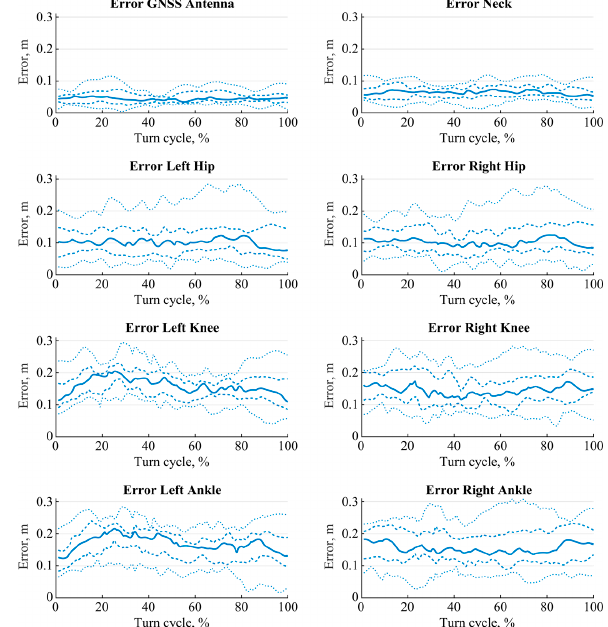
Figure 5. Position error of the GNSS antenna and the joint centers. In each graph the lines are, from bottom to top, the 5th (dotted), 25th (dashed), 50th (solid), 75th (dashed), and 95th (dotted) percentiles.